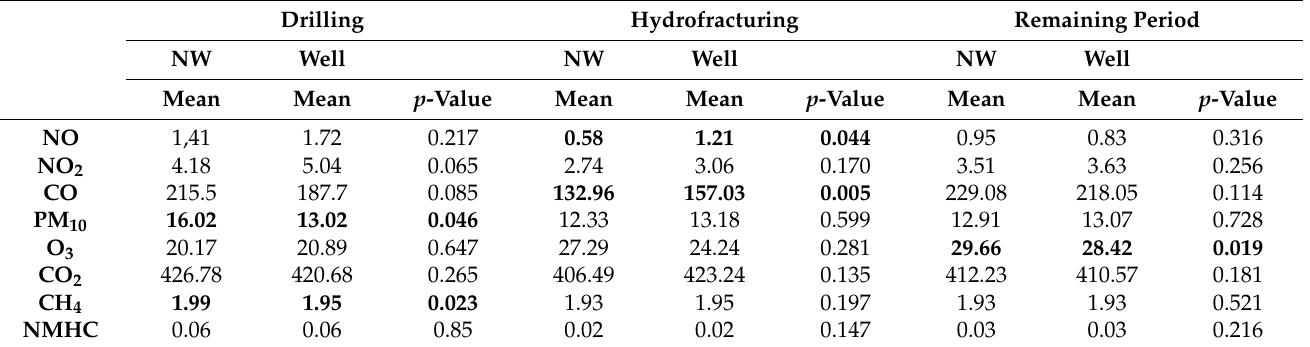
Table 3. Statistical significance according to the t -test results (at α = 0.05) of differences between concentrations of individual air pollutants for the air coming to the measurement point directly from the wells area and from the NW sector during drilling, hydrofracturing, and the remaining period. Note: Statistically significant cases ( p -value < 0.05) are bolded. Units as shown in Table 2, except CH 4 (ppm) and NMHC